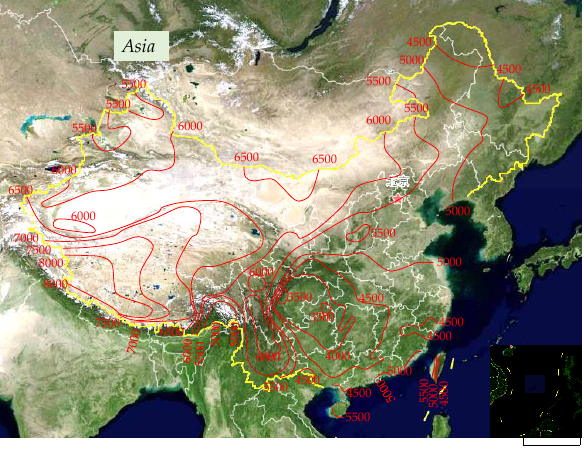
Figure 2. Distribution of annual total solar radiation (MJ/m 2 ) in China from 1990 to 2020 [42,43].